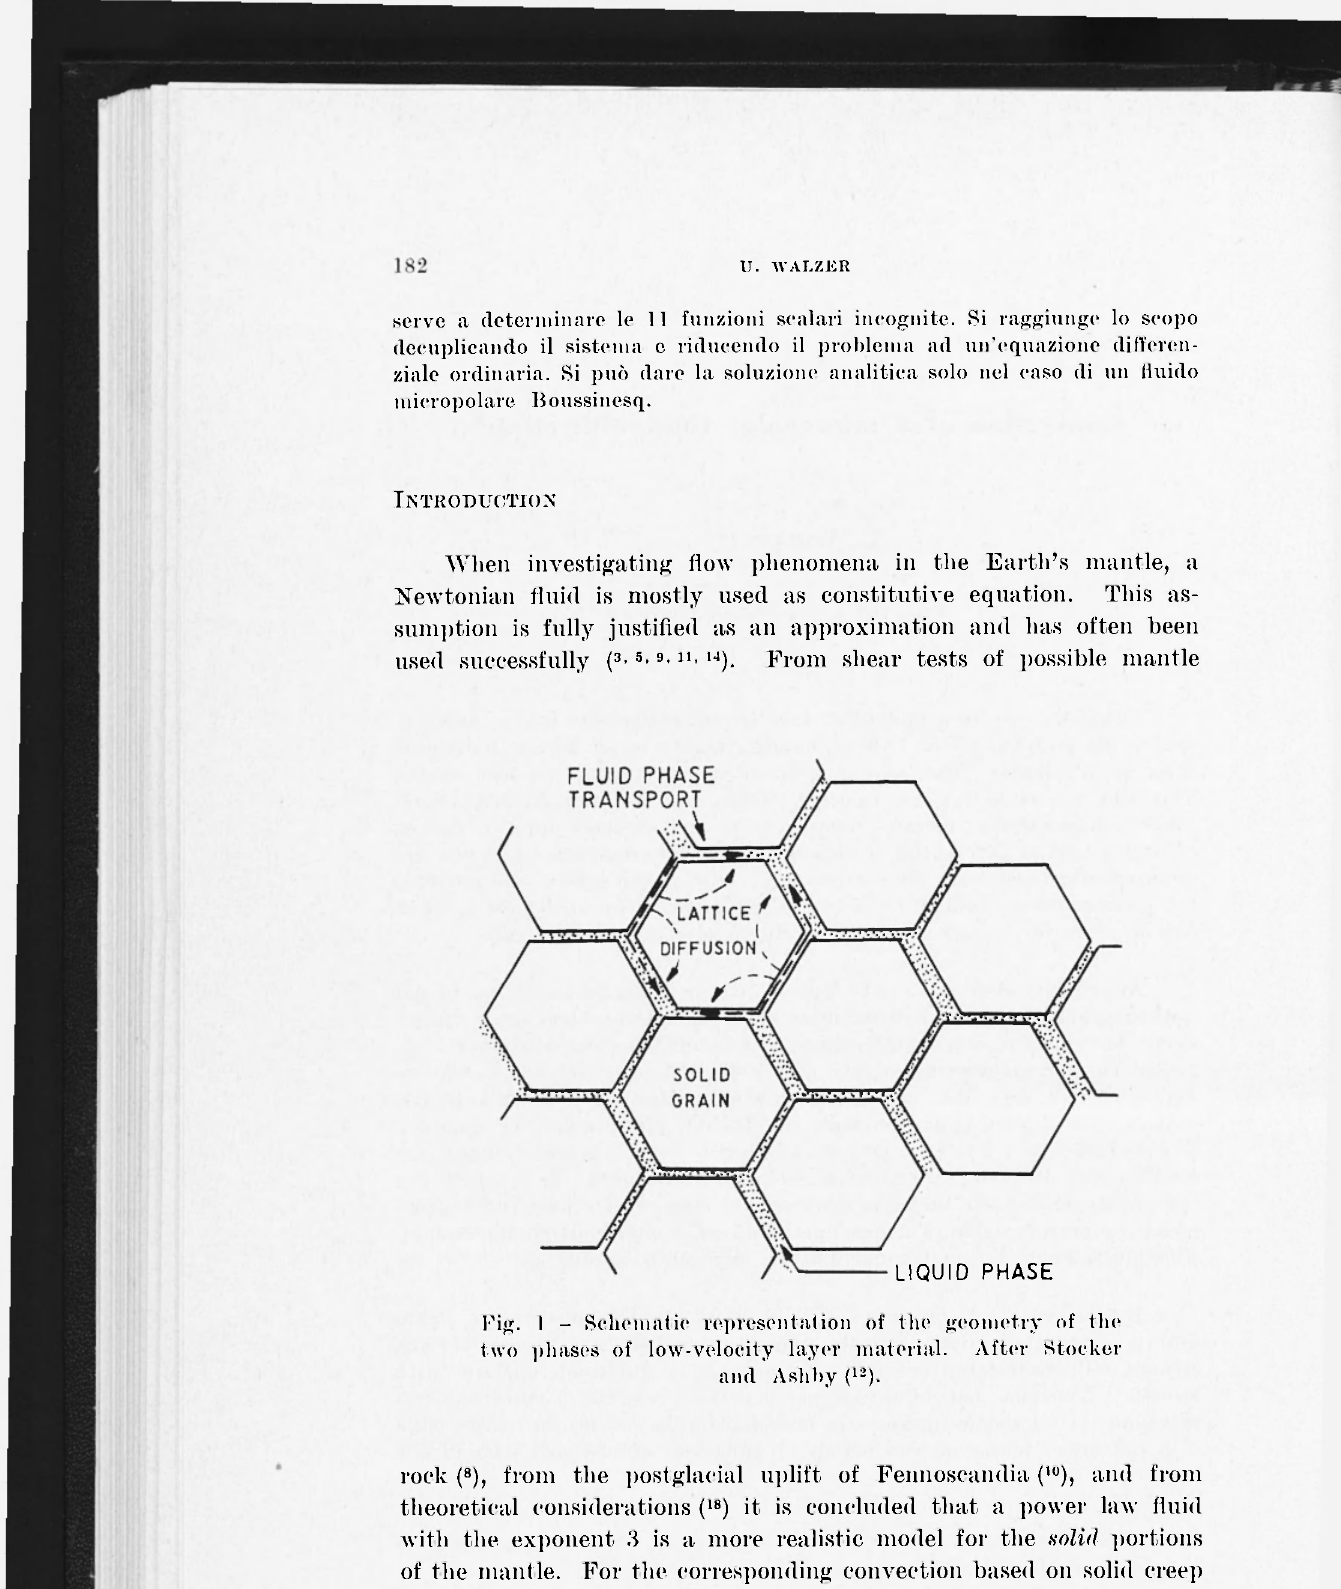
Fig. I - Schematic representation of the geometry of the two phases of low-velocity layer material. After Stocker and Ashby ( 12